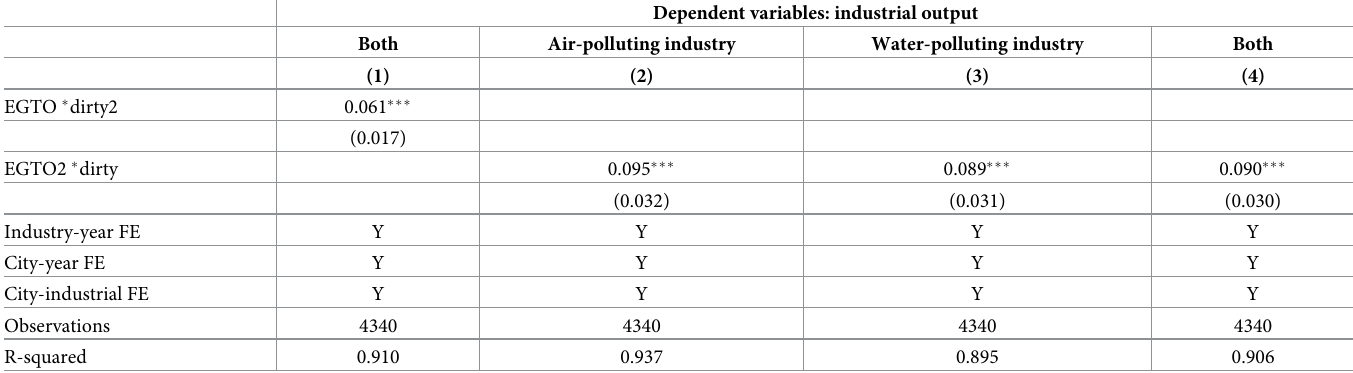
Table 3. Alternative measures of high-polluting industry and